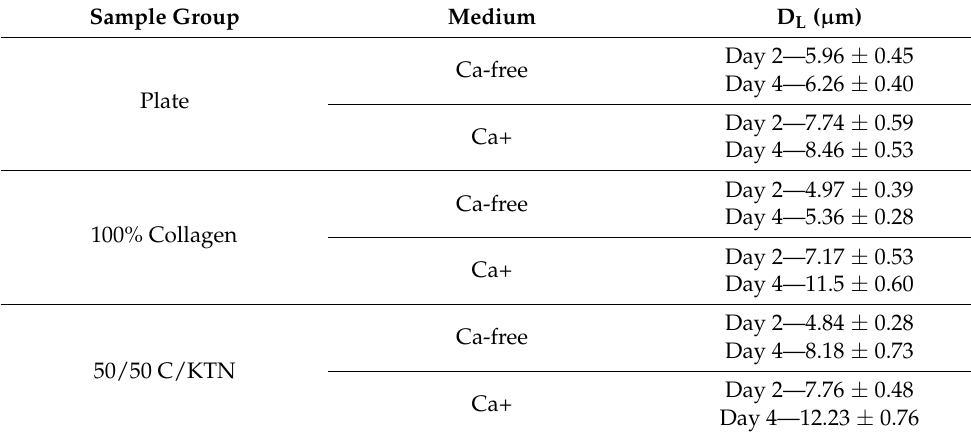
Table 3. D L of measured lysosomes tagged with LysoTracker staining. Measurements are displayed as average ± SEM with n =